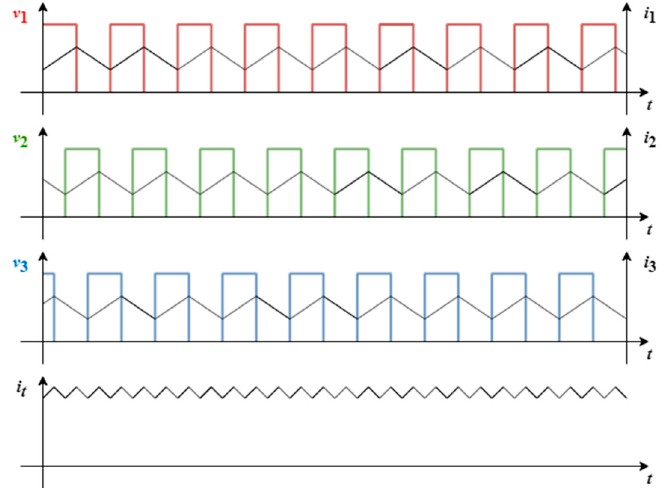
Figure 5. Pole voltages, inductor currents, and total current in 3-leg interleaved buck converter in case of d 1 = d 2 = d 3 = 0.5.